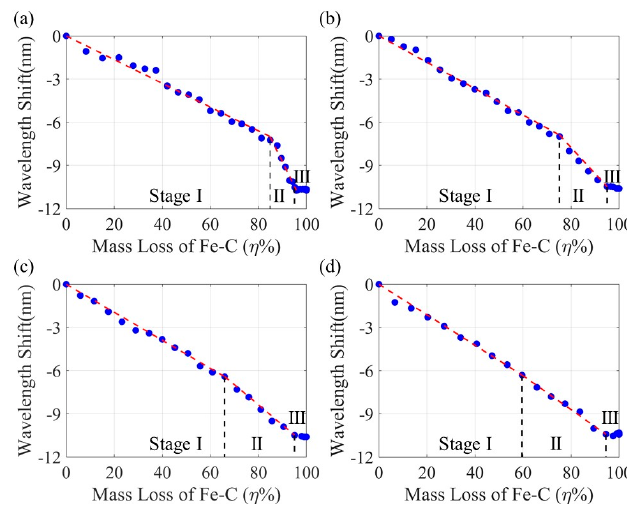
Figure 15. Resonant wavelength shift with Fe-C mass loss at ( a ) 0, ( b ) 500, ( c ) 1000 and ( d ) 1500 µ ε .